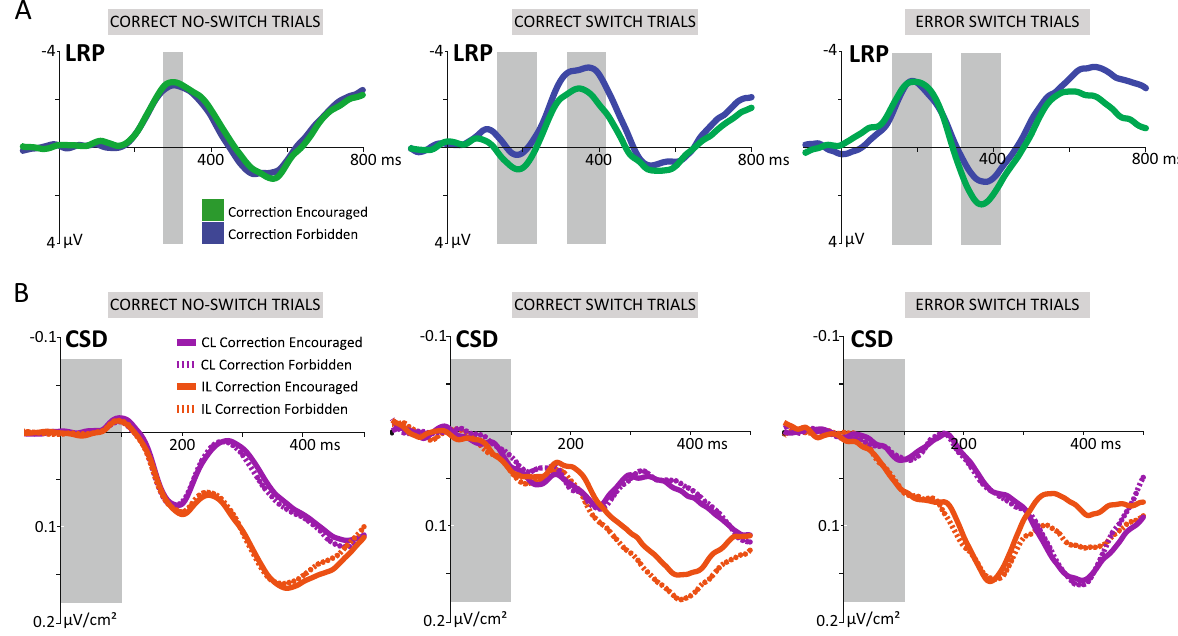
Figure 4. ( A ) S-locked LRPs in correct no-switch, correct switch and error switch trials for Encouraged and Forbidden correction conditions. The gray boxes indicate the analyzed time windows associated to the response preparation and, if required, to the processing of the switch. ( B ) Grand average S-locked CSD waveforms of the contralateral (purple) and ipsilateral (orange) motor preparatory activity separately for correct no-switch, correct switch and error switch trials. Solid lines represented the Encouraged correction condition whereas dashed lines correspond to trials in which the correction had to be withheld. IL, ipsilateral; CL, contralateral.